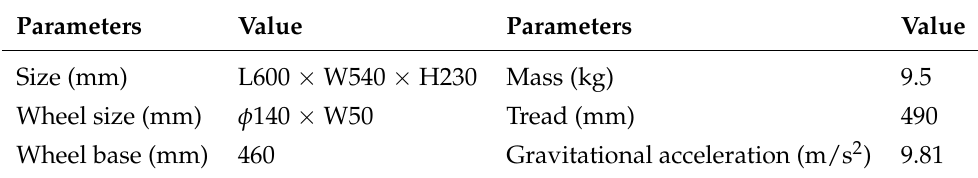
Table 2. Specifications of the rover